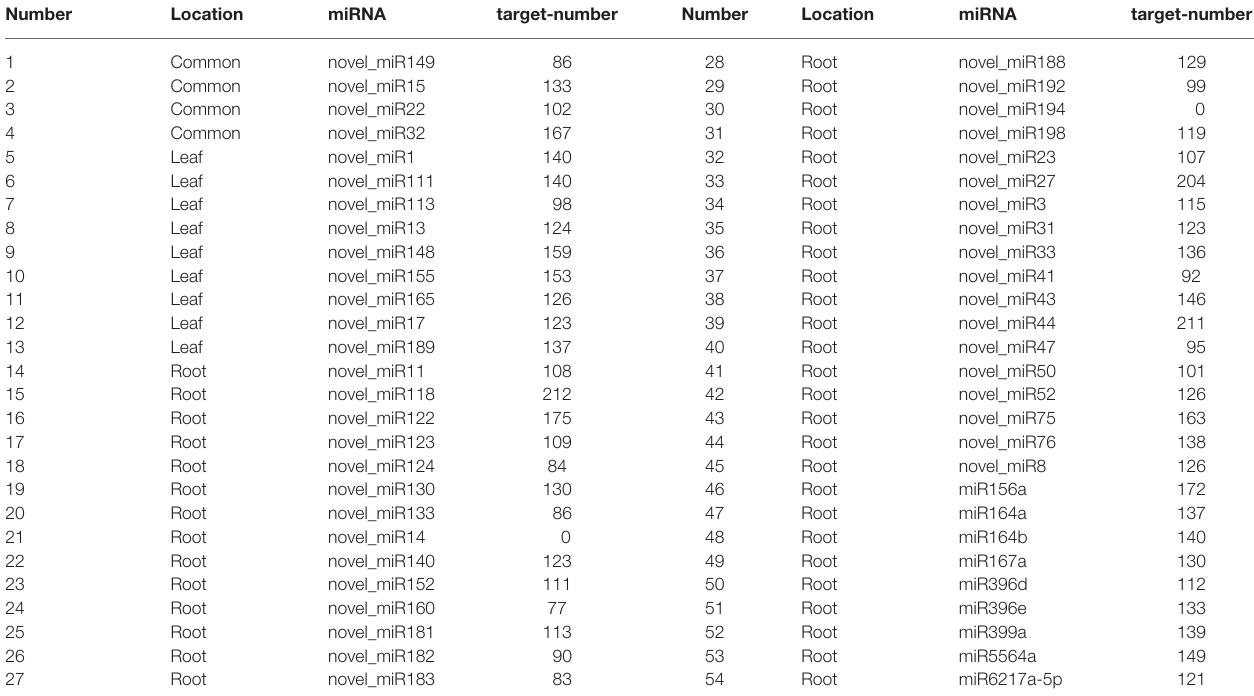
TABLE 2 | Numbers of differentially expressed miRNA targets in leaf and root